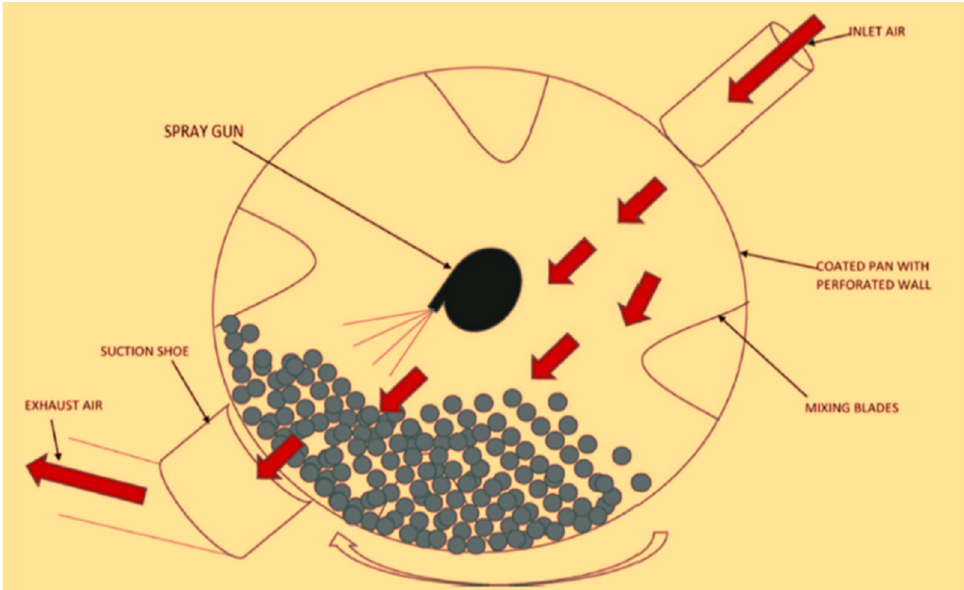
Figure 8. Panning application method of an edible coating. Adopted from [194] with permission.